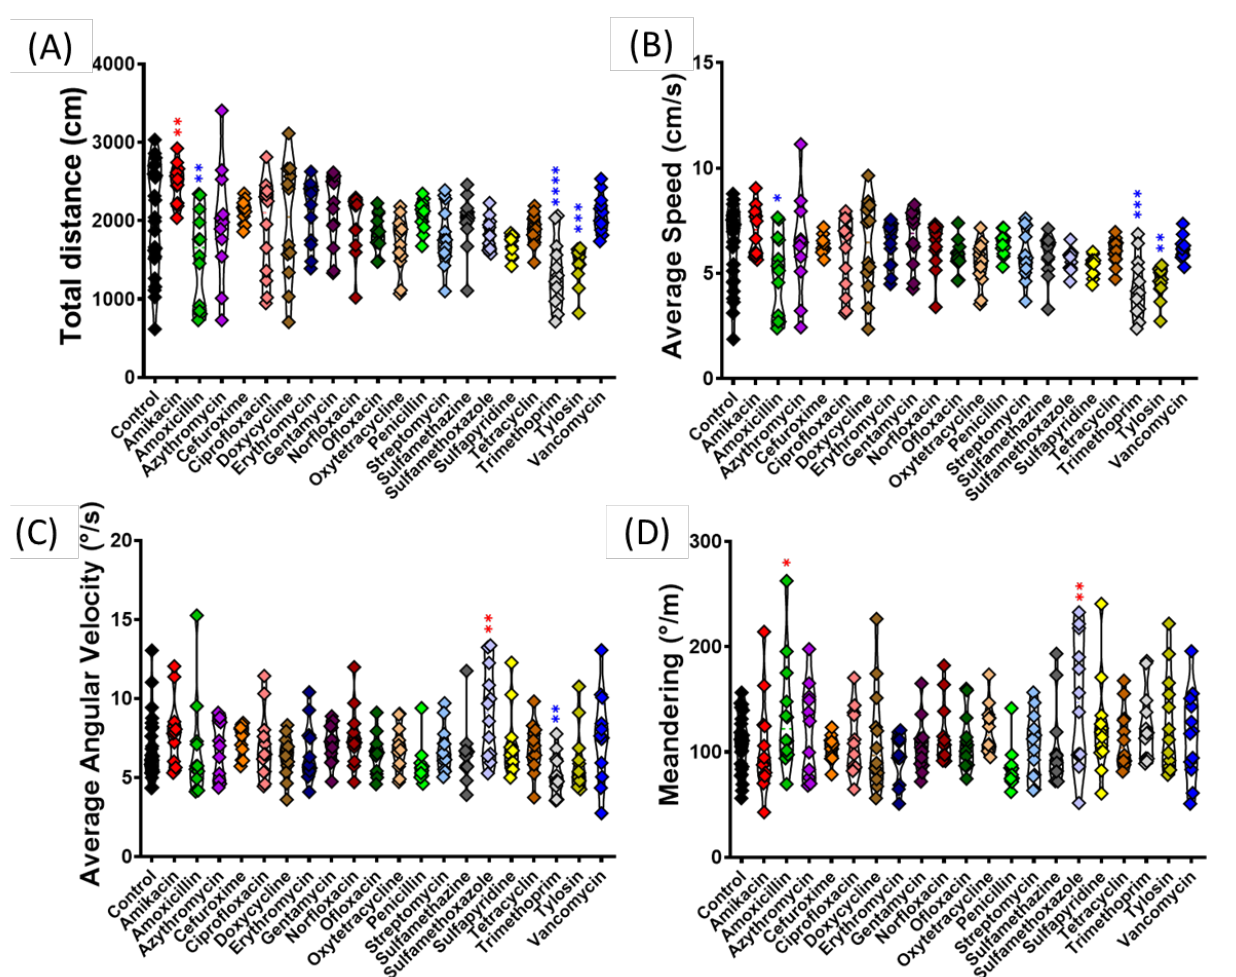
Figure 3. Comparison of locomotor activity endpoints of golden zebrafish after 10 days exposure with different antibiotics in 3D locomotion test. ( A ) Total distance; ( B ) average speed; ( C ) average angular velocity; and ( D ) meandering. The data were analyzed by ordinary one-way ANOVA followed by multiple comparison Fisher’s LSD test ( n control: 24, n for each antibiotic group: 12). The significances were indicated by * p < 0.05; ** p < 0.01; *** p < 0.001; **** p < 0.0001 (red asterisk indicates a higher mean value, while blue asterisk indicates a lower mean value than control).